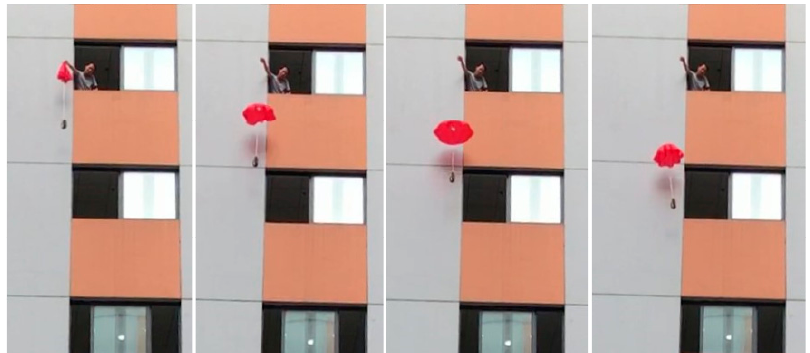
Figure 5. The opening process of the parachute in the airdropped experiment.